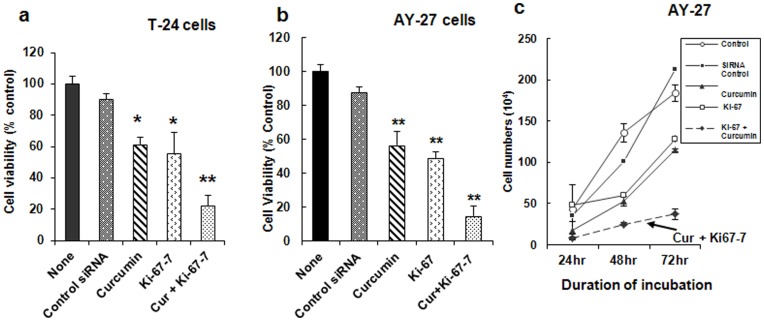
Effect of the combined treatment of anti-Ki-67 DsiRNA and curcumin on bladder cancer cells.Equal number (0.8×105 cells/well) of bladder cancer cells T-24 (3a) and AY-27 (3b) cultured as described in Methods were either transfected with Ki-67–7 or control DsiRNA (10 nM) or treated with the transfection reagent alone for 24 h. Subsequently, where indicated, curcumin (10 µM) was added to the cells and incubated for 24 h followed by an additional 24 h incubation in the absence of curcumin. Cell viability was determined by MTT assay at the end of 72 h from transfection. Cells treated with DMSO plus transfection reagent served as the control. Data presented are the mean ± S.E of 3–5 determinations (*P<0.05, **P<0.01). 3c) AY-27 cells (0.8×105 cells/well) were treated exactly as described above in legend to Figures 3A and 3B and at the end of 24, 48 and 72 h after curcumin treatment (which is same as 48, 72 and 96 h after siRNA transfection), cell growth was assessed based on cell numbers as described in Methods. Data are mean ± S.E of three determinations.